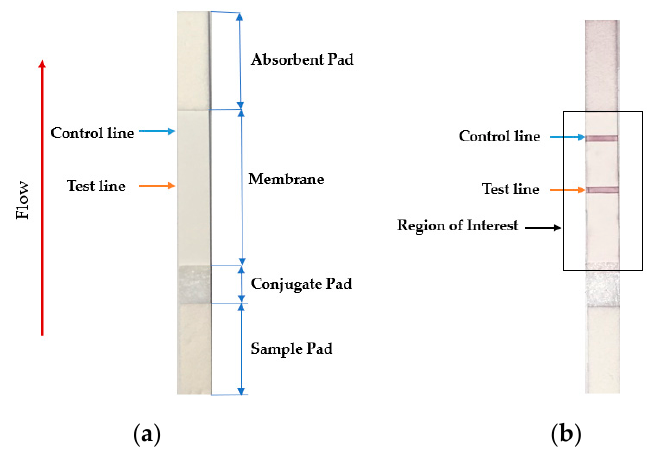
Figure 2. ( a ) Sample LFA strip and ( b ) region of interest of an LFA strip with an analyte. The intensity and density of red color in the test line region determine the amount of analyte in the sample.